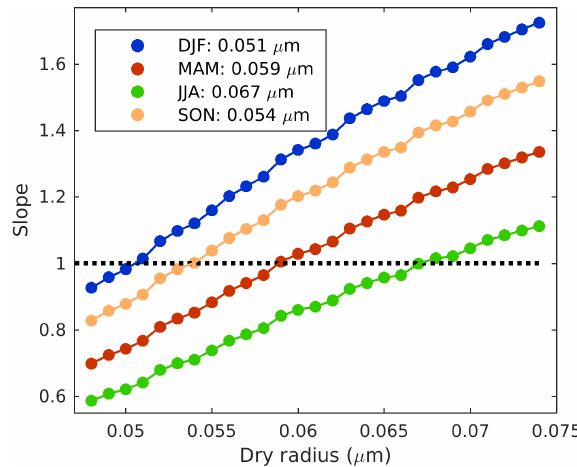
Figure 7. Slope of measured vs. calculated α sp plot vs. dry geomet- ric mean aerosol radius, by season. Winter (DJF) is in blue, spring (MAM) in red, summer (JJA) in green, and fall (SON) in orange. The line slope = 1 is shown in black. Numbers in the legend repre- sent the dry radius for which the slope = 1 for each season.